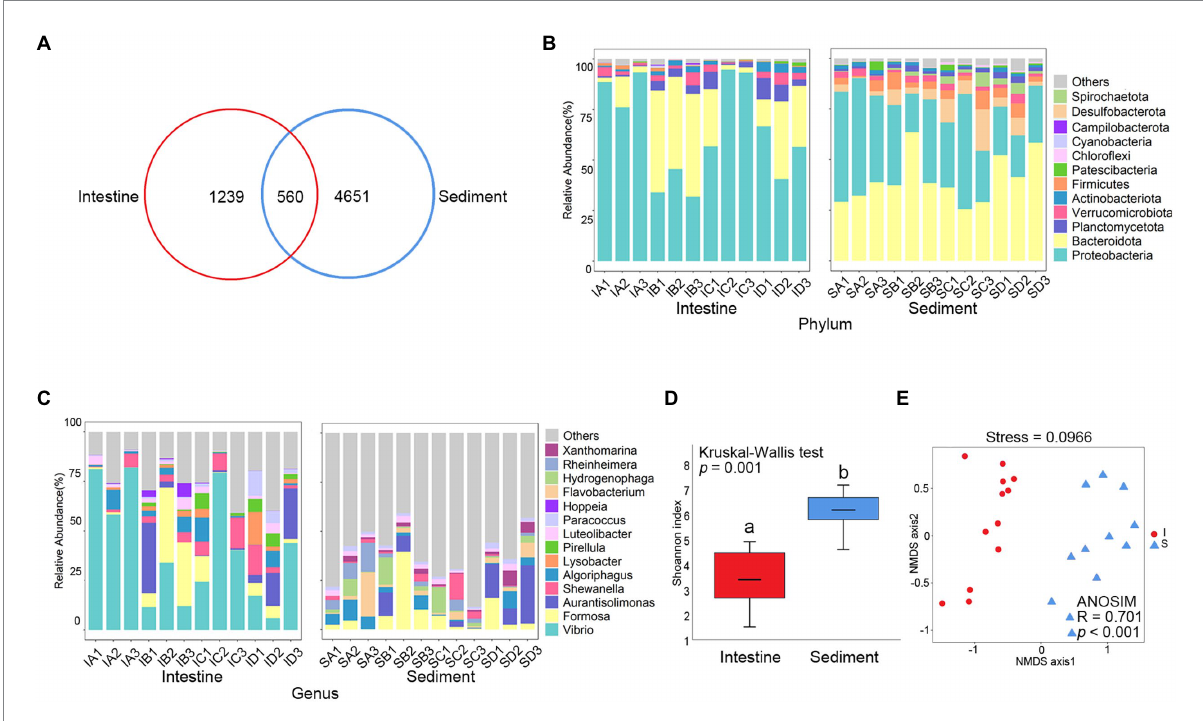
FIGURE 1 Comparative analysis of prokaryotic community between shrimp intestine and sediment. (A) Venn analysis of prokaryotic communities at the amplicon sequence variant (ASV) level among shrimp intestine (red) and sediment (blue). Relative abundances of (B) dominant prokaryotic phyla and (C) dominant prokaryotic genera. (D) Box plots figure showed the range of Shannon index in shrimp intestine (red) and sediment (blue). The significant difference calculated by the Kruskal-Wallis test was shown by marking a and b. (E) The β -diversity of prokaryotic communities of shrimp intestine (red) and sediment (blue) was analyzed by NMDS and ANOSIM based on the Bray-Curtis